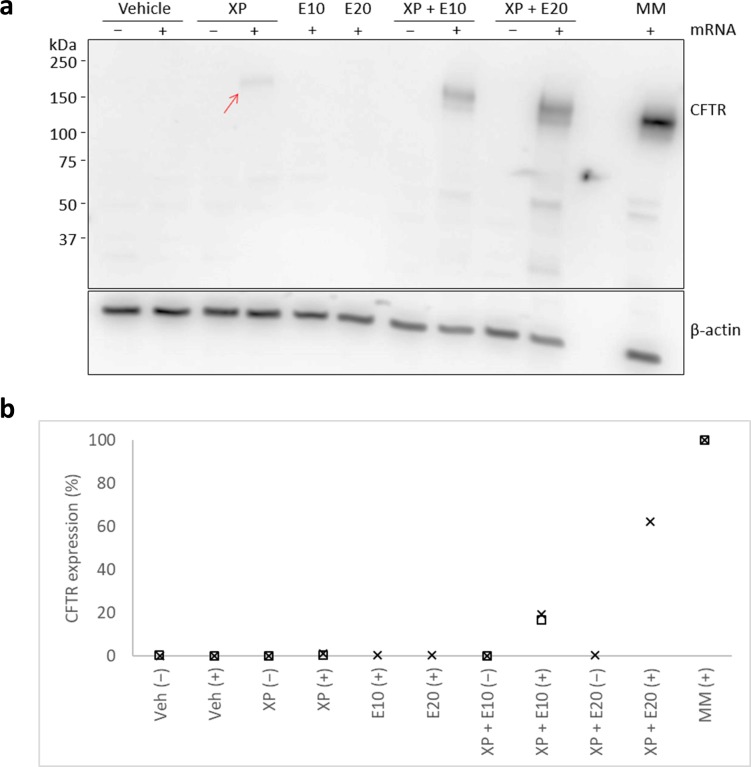
E6446 enhances XP-mediated transfection of CFTR mRNA.Western blot (a) and densitometry (b) analyses of HEK293T cells lysed 24 h after transfection with 5 μg of modified CFTR mRNA (+) or buffer (−) and 10 μg of XP in the presence or absence of 10 (E10) and/or 20 (E20) μM E6446. A control set of cells was transfected with CFTR mRNA using Lipofectamine™ MessengerMax transfection agent (MM). The blot was probed with antibodies against CFTR and β-actin. The position of the CFTR band (170 kDa) is indicated and an arrow points to a faint CFTR band produced by transfection of CFTR mRNA with XP in the absence of E6446. The densitometry analysis, derived from two independent experiments (⊆,≤), shows data points normalised to β-actin expression and relative to the CFTR expression facilitated by transfection using MessengerMax.